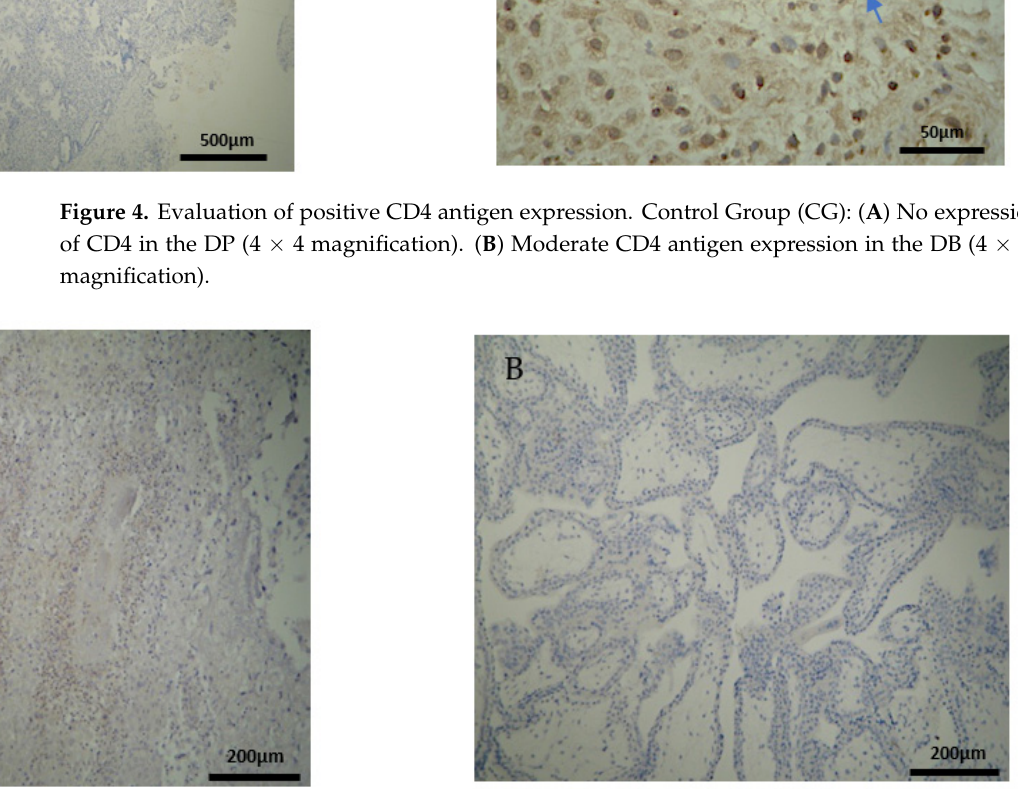
Figure 4 . Evaluation of positive CD4 antigen expression. Control Group (CG): ( Α ) No expression of CD4 in the DP (4 × 4 magnification). ( Β ) Moderate CD4 antigen expression in the DB (4 × 40 magni- fication).